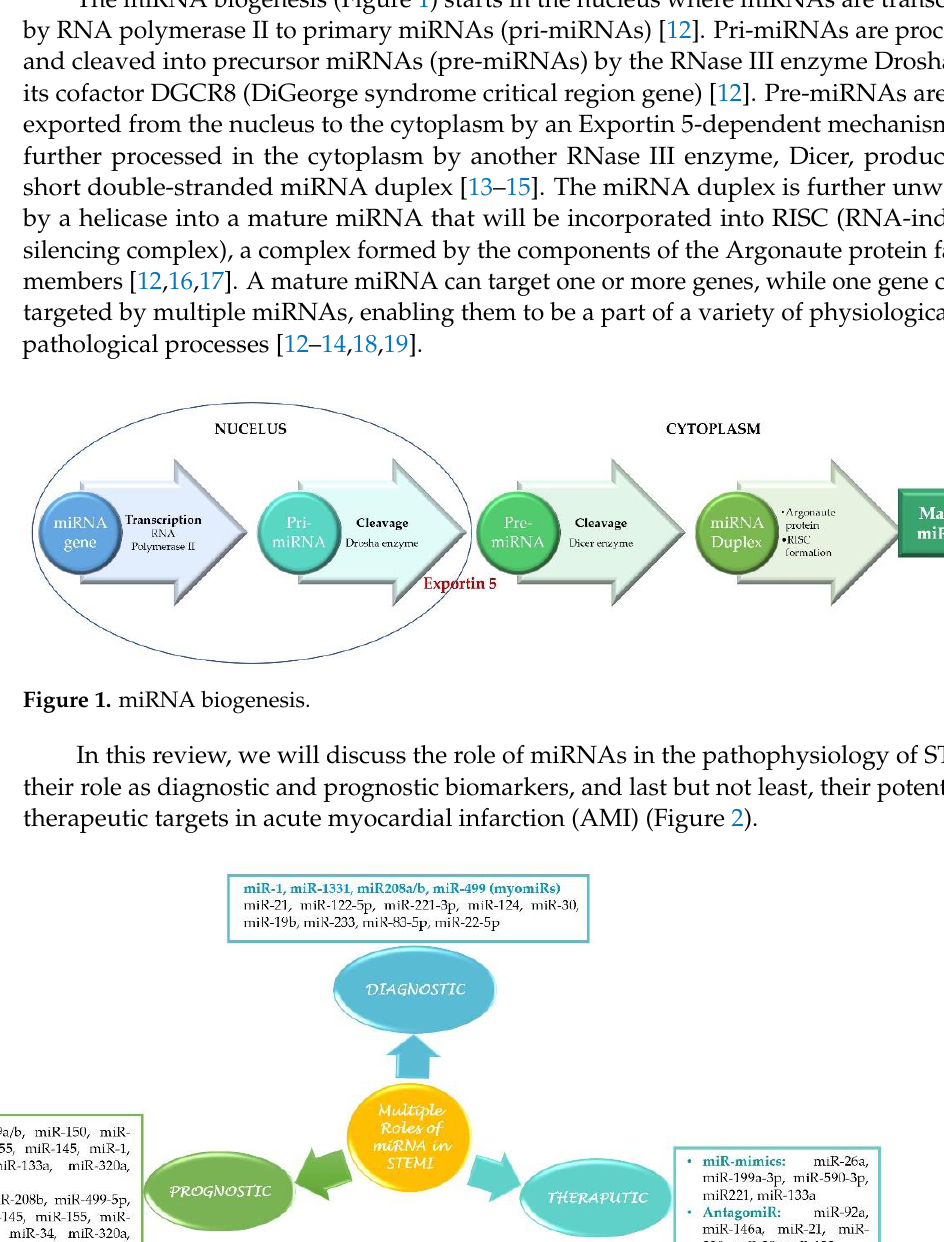
miRNAs appear to have a role in the development and progression of ischemic heart disease at multiple levels (angiogenesis, platelet activation, atherogenesis, lipoprotein ho- meostasis, etc.) [20]. It is suggested that miRNAs play a critical role in the STEMI patho- physiological process as well. Pathophysiologically, acute myocardial infarction (MI) is commonly defined as a car- diomyocyte death due to a prolonged ischaemia resulting from an acute imbalance be- tween oxygen supply and demand [21]. Atherosclerosis, one of the major contributors to CAD and MI, is a chronic inflammatory disease of the arterial wall. The initiation and progression of atherosclerotic plaques is a multistage process with key signaling and mo- lecular regulatory pathways [22]. Following the disruption of a vulnerable atherosclerotic plaque, it’s underlying thrombogenic core is exposed to the blood stream, resulting in thromboembolism (platelets adhere to the site of a rupture and release pro-inflammatory mediators, leading to thrombus formation) and subsequent acute coronary obstruction [23]. 2.1. Atherosclerosis miRNAs have emerged as important regulators of pathophysiological processes such as cellular adhesion, proliferation, lipid uptake, generation of inflammatory mediators. Their involvement in atherosclerotic plaque rupture/erosion is of great clinical im- portance. Plaque disruption with thrombus formation is thought to be the major patho- genetic mechanism for ACS [3]. Vulnerable atherosclerotic plaques (rupture prone) are associated with the presence of a large necrotic core covered by a thin fibrous cap, highly inflammatory cell content, and also a decreased number of smooth muscle cells (SMCs) in the fibrous cap [3]. Plaque rupture and plaque erosion are the two main plaque pheno- types in patients with STEMI. Morphologically, ruptured plaques are usually rich in lipids with macrophage infiltration, while the main components of eroded plaques are proteo- glycans and SMCs [24]. Many studies demonstrated the implications of miRNAs in processes related to the risk of atherosclerotic plaque rupture/erosion. For example, miR-24 downregulation proved to enhance macrophage apoptosis, promoting plaque progression and instability [25], while miR-29 is involved in plaque stabilization by suppressing IFN-g (interferon gamma) production (IFN-g contributes to fibrous cap thinning by inhibiting the ability of SMCs to express the genes that encode procollagens) [26,27]. Overexpression of miR-145 increases stability (increased collagen content and fibrous cap area); miR-126 is linked to plaque stabilization — it increases SMCs and collagen content and reduces apoptotic cells [28]; miR-150 inhibits the formation of foam cells from macrophages exposed to the action